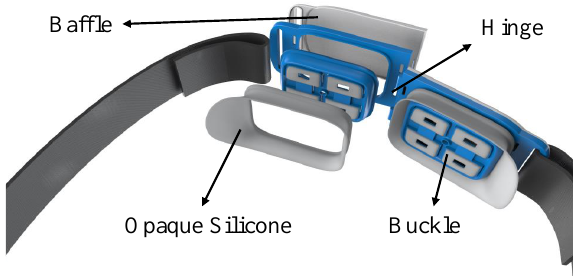
Figure 3. The wearable design of the measurement system.